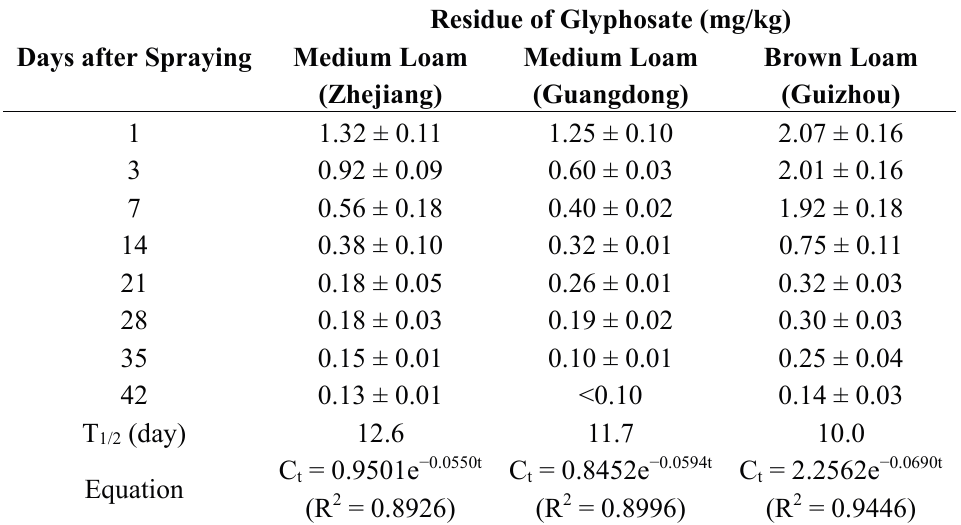
Figure 2. Chromatogram of glyphosate and AMPA standard and soil samples in 2008 field experiments. Table 2. Degradation dynamics of glyphosate soluble powder in different type of